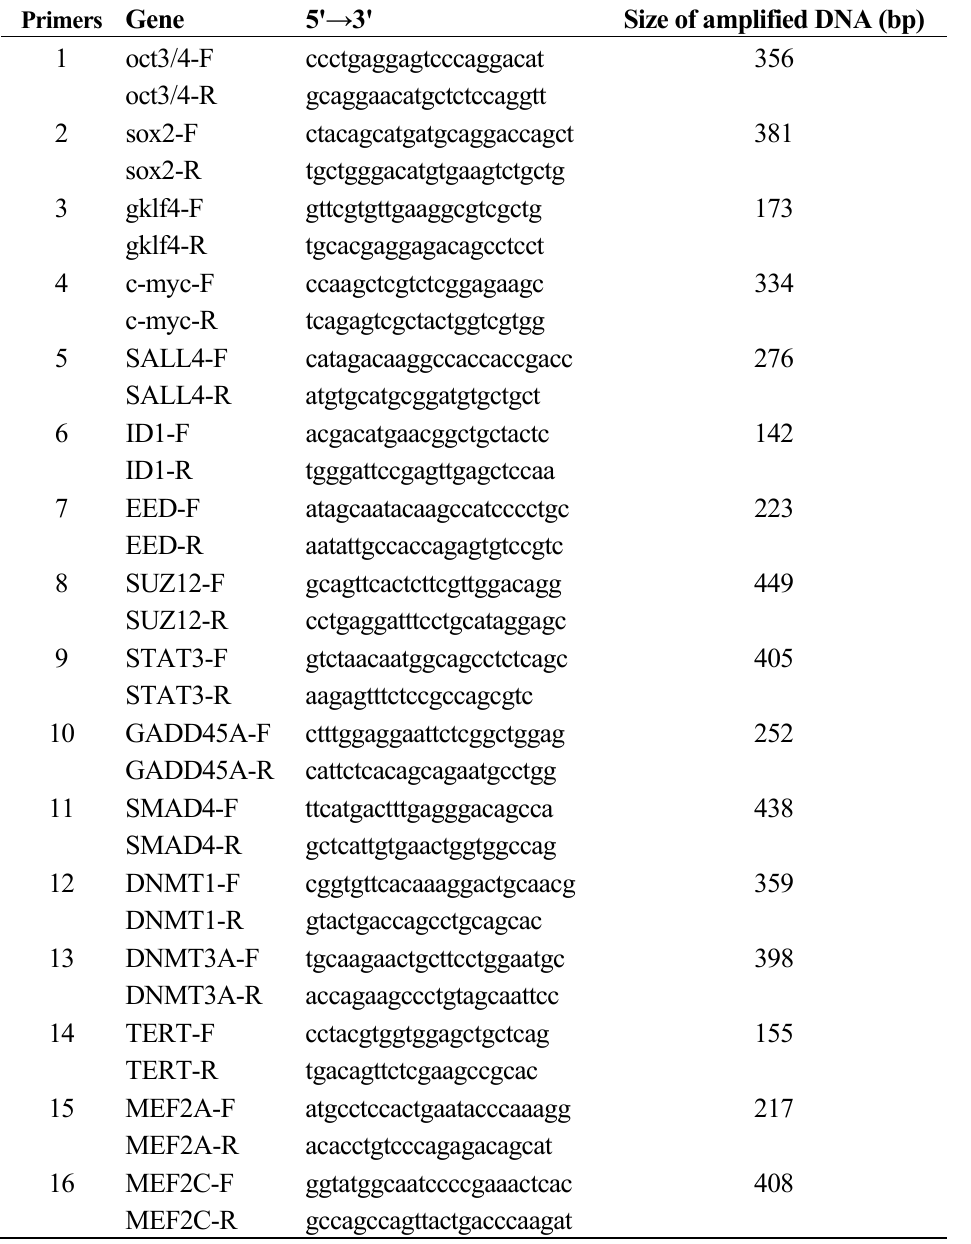
Table 2. Nucleotide sequences of the primers used for stemness-related genes and the expected sizes of the DNA